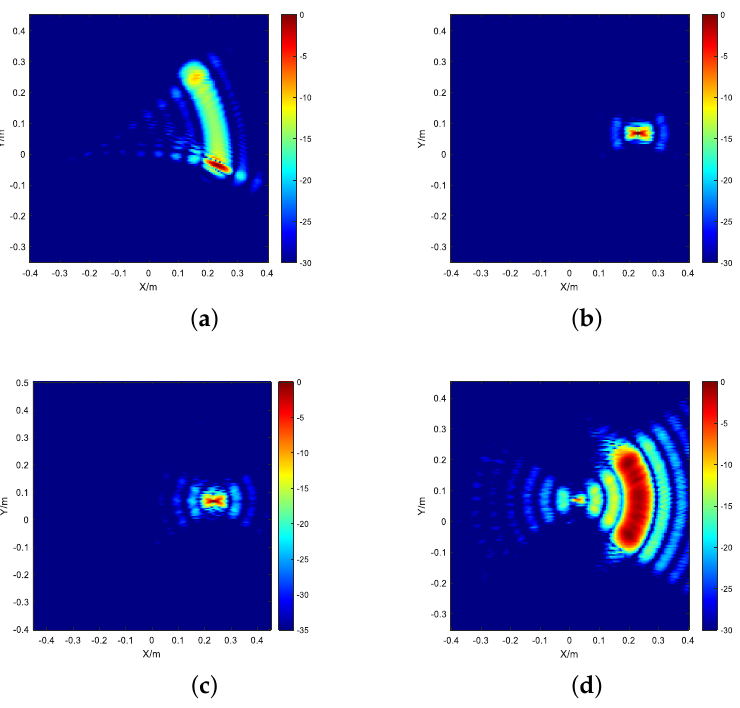
Figure 15. Real-data experimental imaging results of the metal arc cylinder: ( a ) the BP result of the real trajectory; ( b ) the PGA result; ( c ) the MSE result; ( d ) the proposed SPA-GAN result.